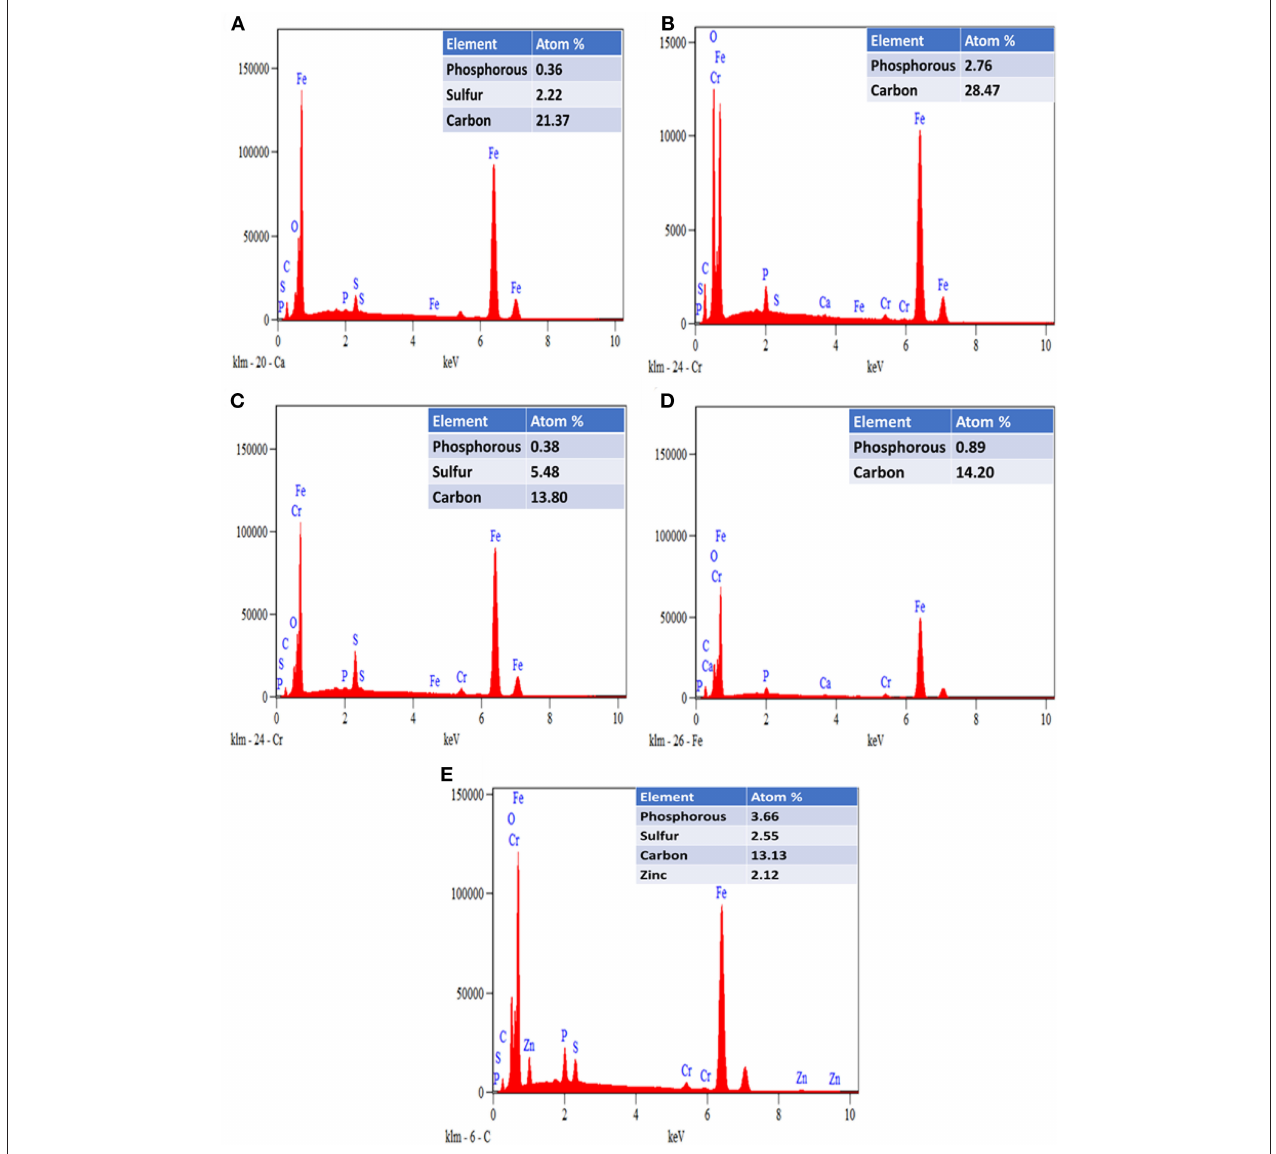
FIGURE 9 | Energy dispersive spectroscopy spectra of four ball wear scars for grease blends with (A) MWCNT_P IL1 (B) MWCNT_P IL2 (C) MWCNT_N IL1 (D) MWCNT_N IL2 (E)